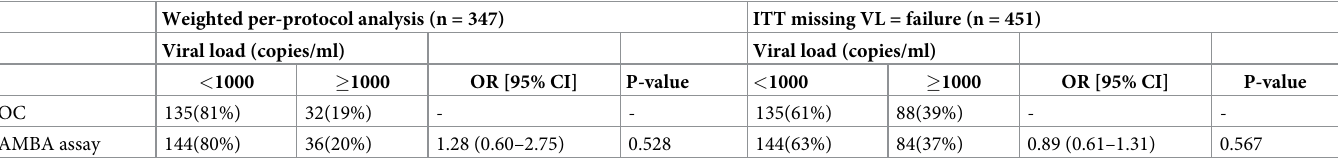
Table 2. Effect of the clinic-based SAMBA assay on viral load suppression compared to SOC. Weighted per-protocol analysis (n =